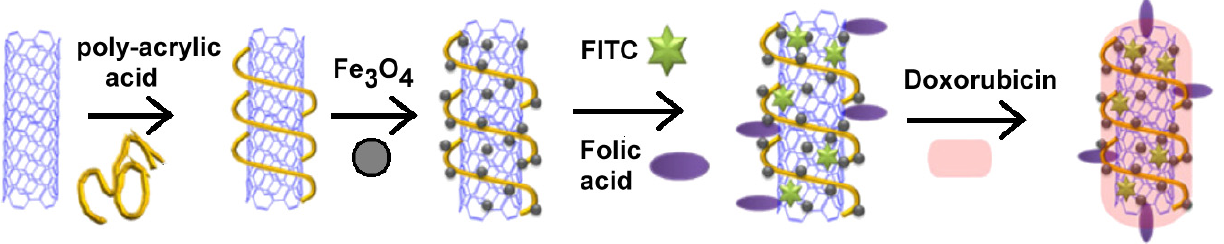
coating of CNTs with a polymeric material, attachment of iron oxide nanoparticles to the polymer, fluorescent probe (FITC) and targeting molecules (folic acid) attachment and finally coating with